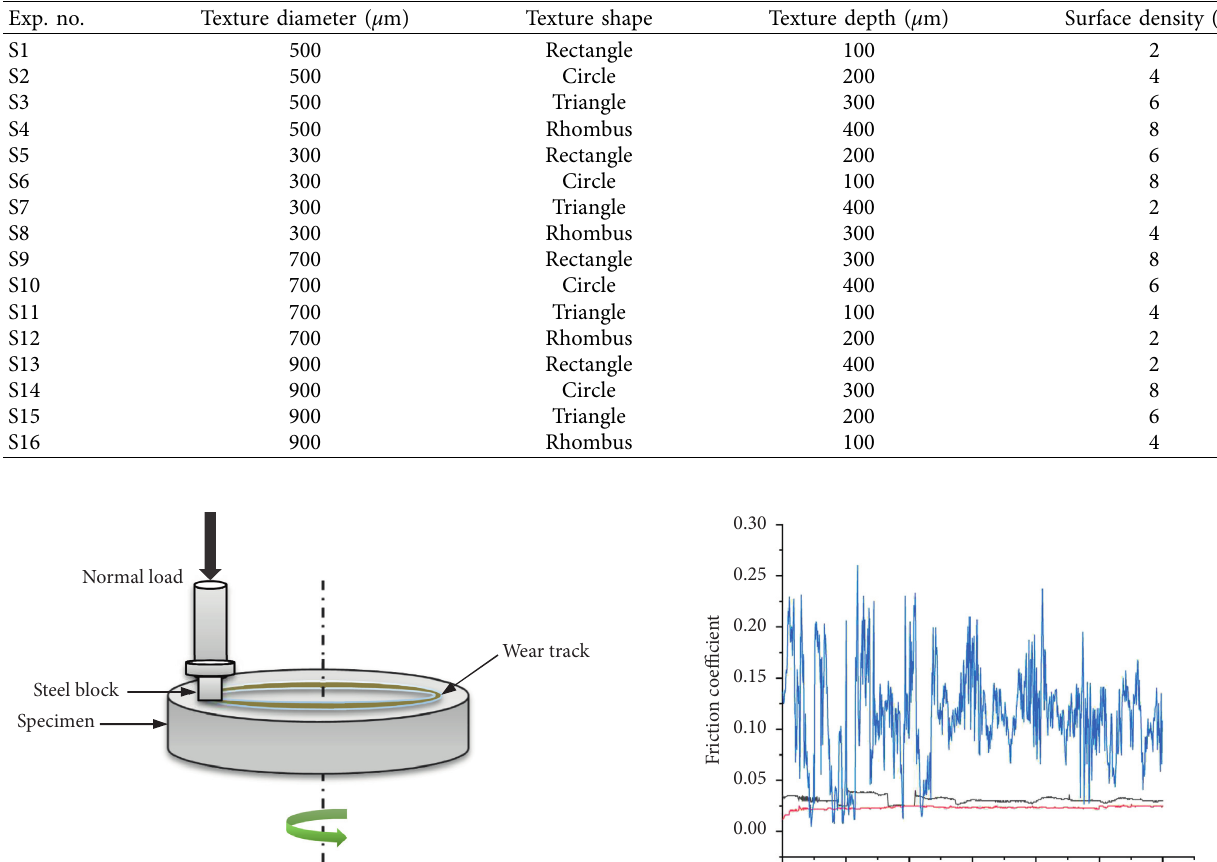
Table 2: The L 4 ) orthogonal array of texture parameters. 16 (4